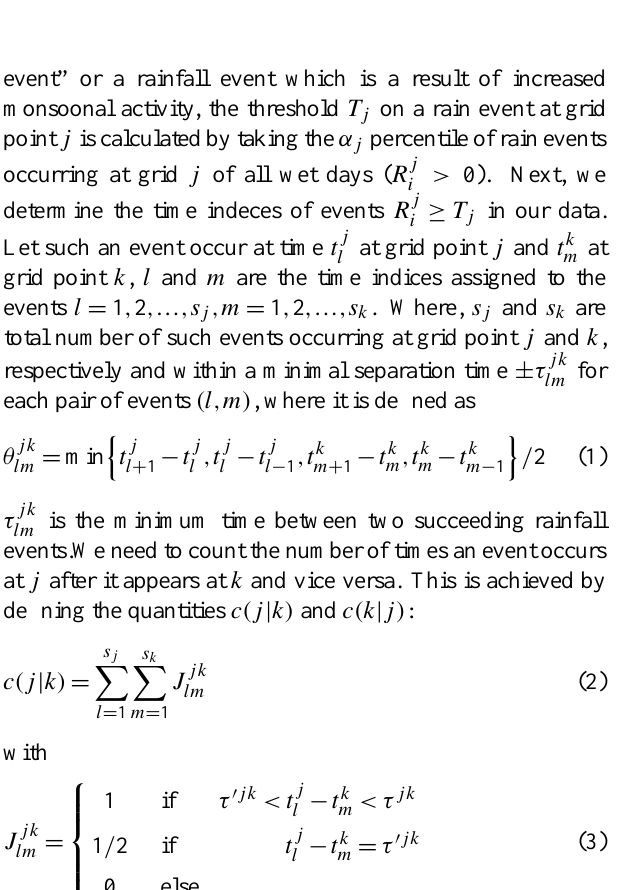
Fig. 3. Variance of the mean seasonal rainfall at each grid point. The colour scale is relative hence each grid point could be compared with the any other grid point (data used APHRO–V0902)